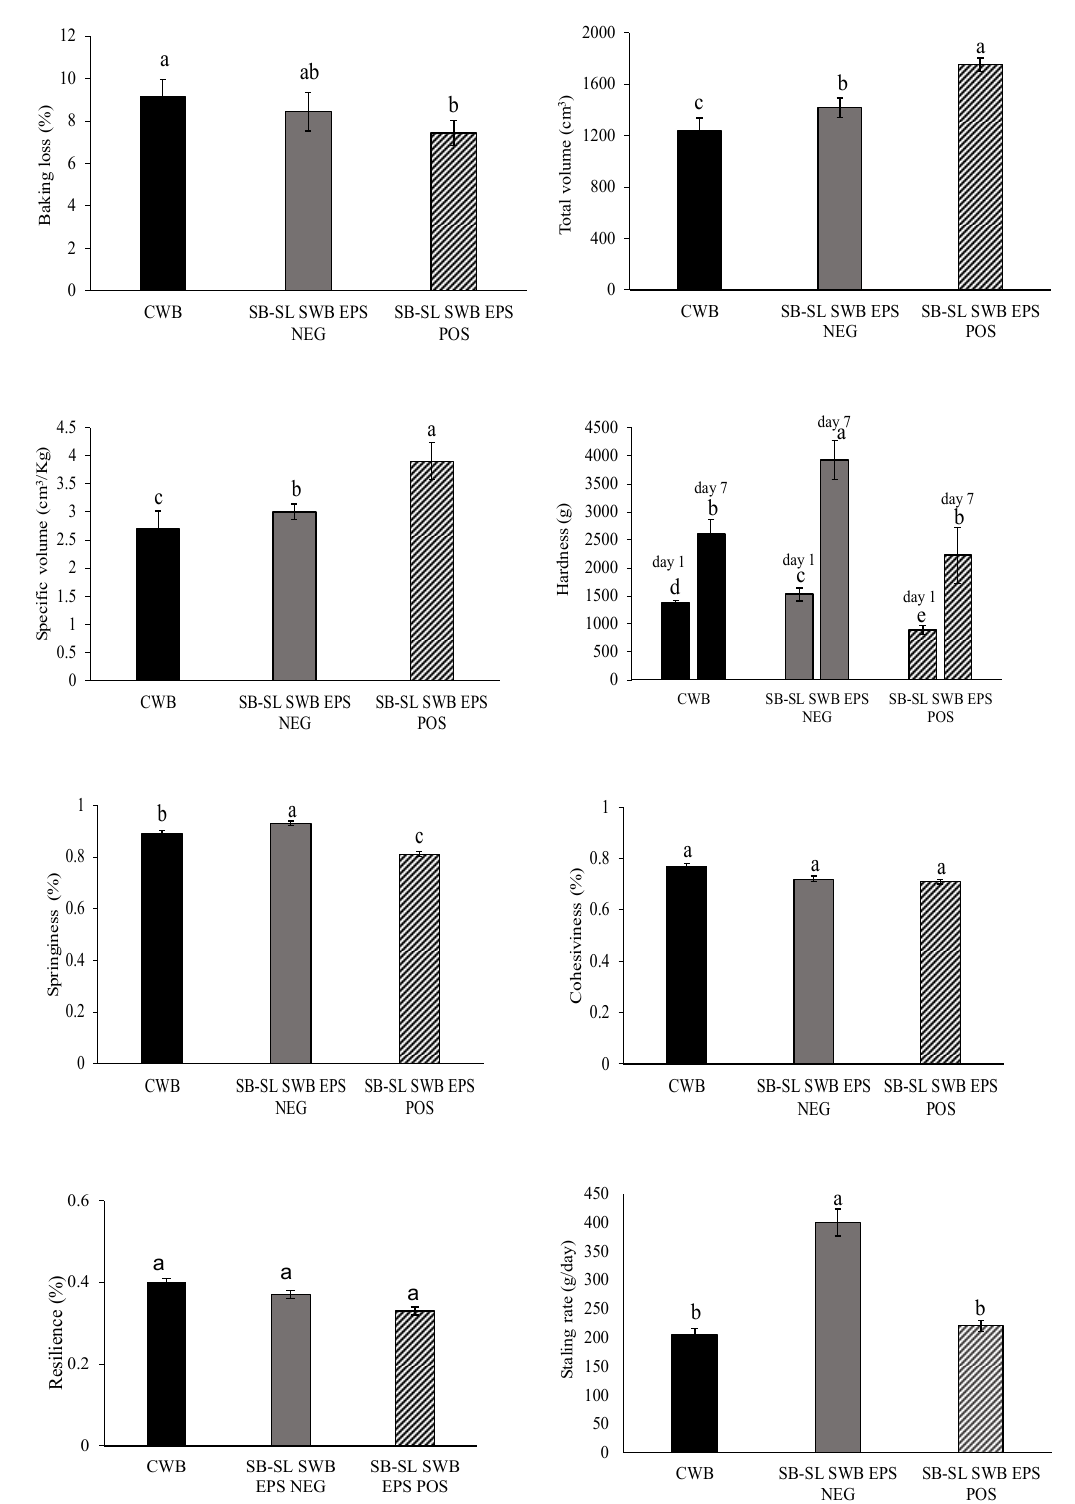
Figure 2. Technological characteristics of control and sourdough breads (DY 162). CWB, control wheat bread started with baker’s yeast; SB-SL SWB EPS NEG, bread containing wheat flour added with 30% ( w / w ) sprouted barley–sprouted lentil (30:70% w / w ) sourdough fermented by Leuconostoc pseudomesenteroides DSM 20193; SB-SL SWB EPS POS, bread containing wheat flour added to 30% ( w / w ) dextran-containing sprouted barley–sprouted lentil (30:70% w / w ) sourdough fermented by L. pseudomesenteroides DSM 20193. The initial cell density of the strain was ca. 7 log cfu/g. The sourdough was fermented at 20 ◦ C for 24 h. For each bread, bars with different superscript letters differ significantly ( p <